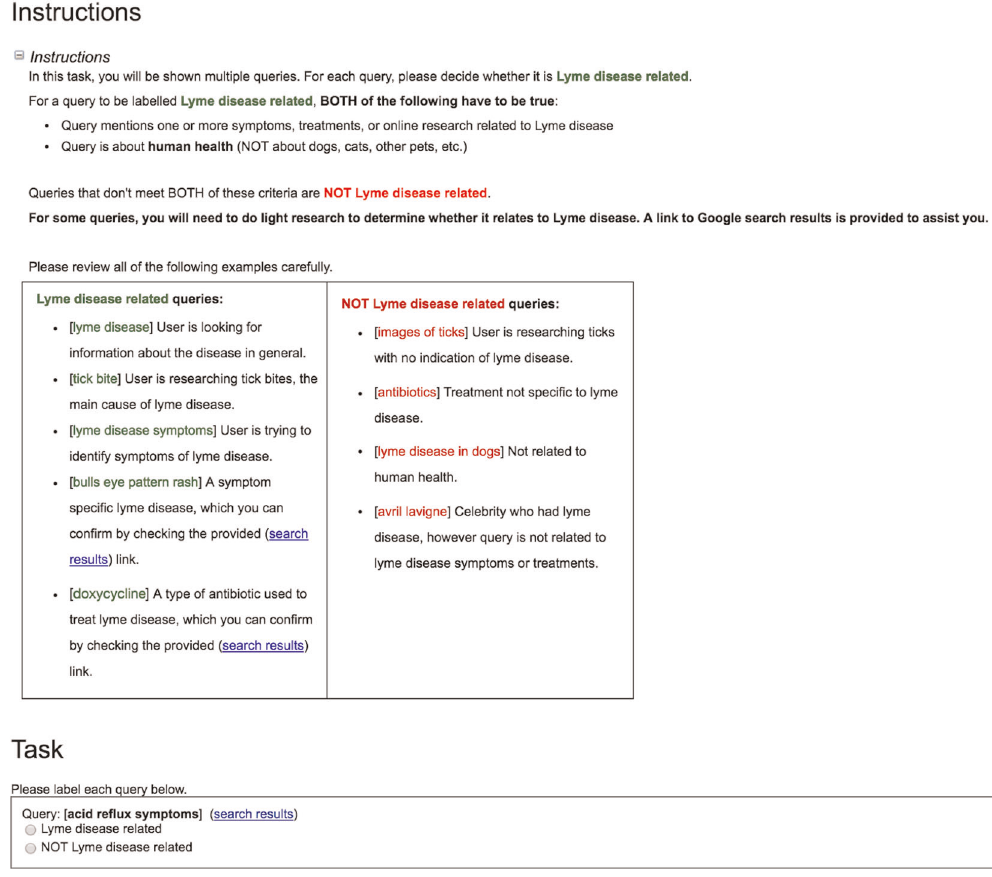
Fig. 1 Task de fi nition for obtaining human judgements on queries. The same template was used to solicit labels from non-medical professionals as well as from medical doctors.